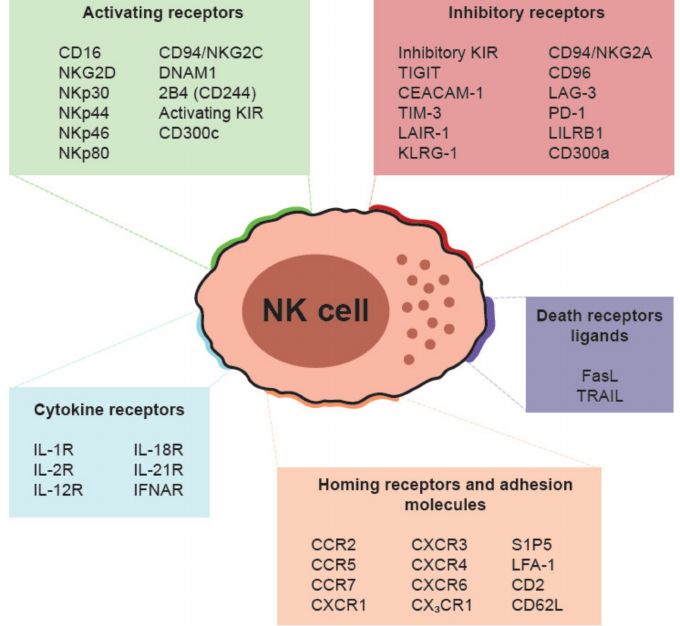
Figure 1. Surface receptor repertoire of human natural killer (NK) cells. DNAM1: DNAX accessory molecule 1. KIR: Killer-cell immunoglobulin-like receptors. TIGIT: T-cell immunoreceptor with Ig and ITIM domains. CEACAM-1: Carcinoembryonic antigen-related cell adhesion molecule 1. TIM-3: T-cell immunoglobulin and mucin-domain containing 3. LAIR-1: Leukocyte-associated immunoglobulin-like receptor 1. KLRG-1: Killer cell lectin-like receptor subfamily G member 1. LAG-3: Lymphocyte activation gene 3. PD-1: Programmed cell death protein 1. LILRB1: Leukocyte immunoglobulin-like receptor subfamily B member 1. FasL: First apoptosis signal ligand. TRAIL: Tumor necrosis factor-related apoptosis-inducing ligand. CCR: C-C chemokine receptor. CXCR: C-X-C chemokine receptor. CX3CR: CX3C chemokine receptor. S1P5: Sphingosine-1-Phosphate receptor 5. LFA-1: Lymphocyte function-associated antigen